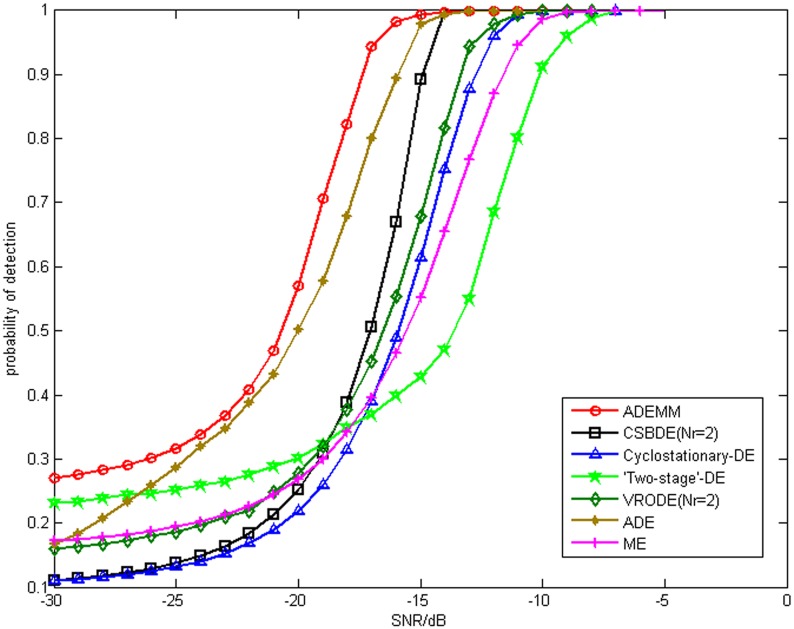
Performance comparison among different detection schemes.